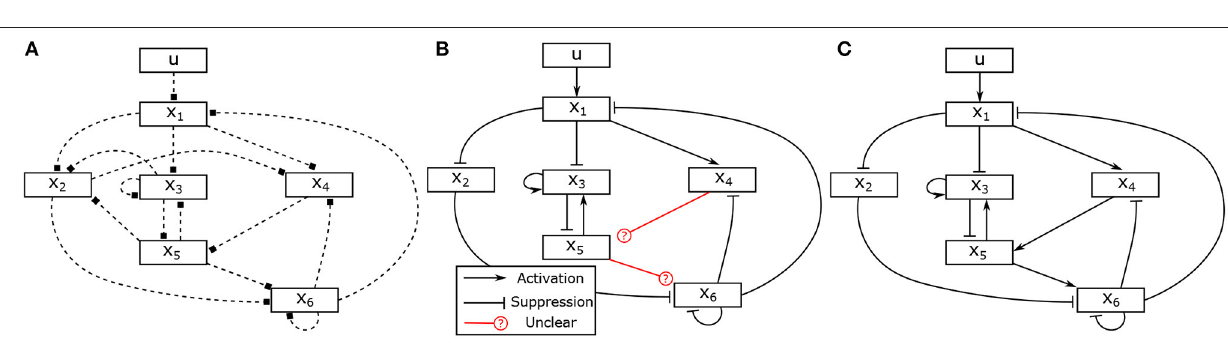
FIGURE 2 | Perturbation and state measurement. (A) First experiment. (B) Second experiment.